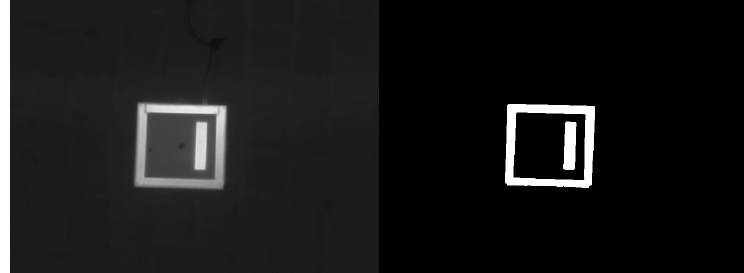
Figure 2. The binary threshold operation applied to the infrared